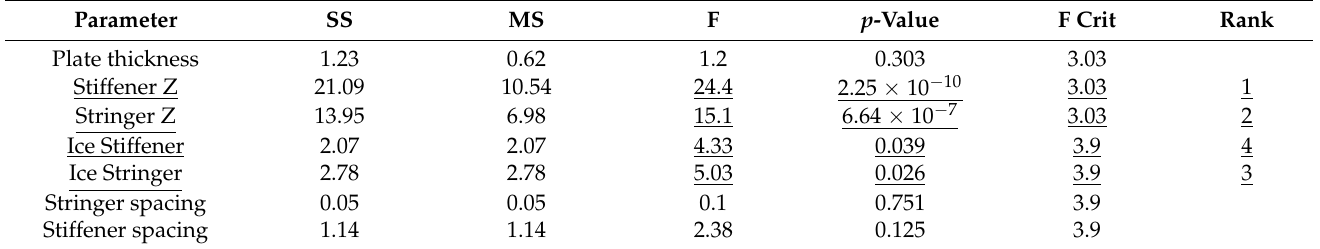
Table A1. Structural steel grillage SSF: Statistically significant parameters are underlined.